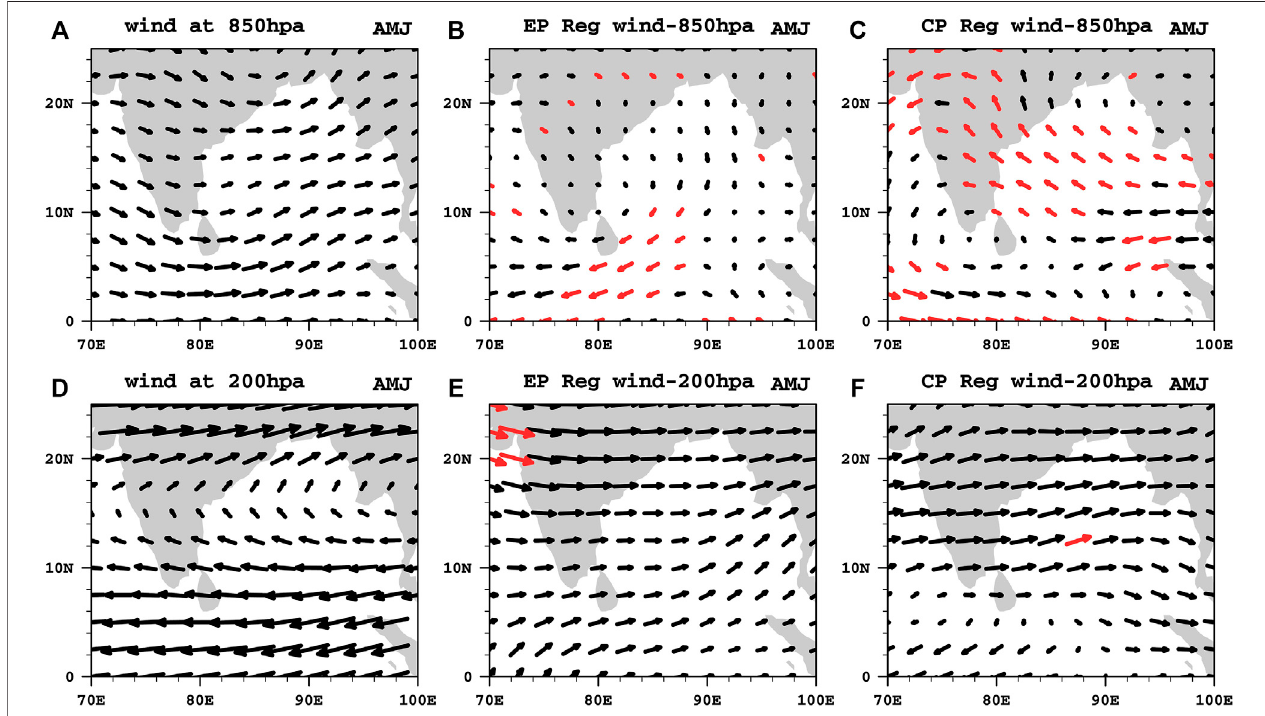
FIGURE14| Climatologicalwind at850 hPa inAMJ (A) ;windvectorsat 200hParegressed withtheEPindex (B) andCPindex (C) . (D – F) same asforupperpanel but at 200 hPa. Red vectors are statistically signi fi cant at the 90% level.